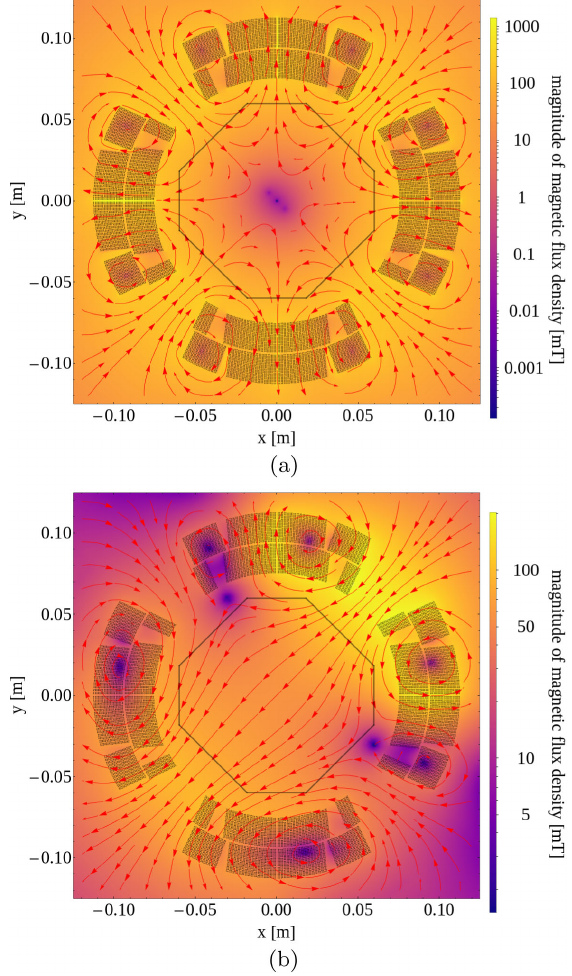
FIG. 6. The magnetic field induced by a CLIQ discharge in the IP1 and IP5 final focusing triplet magnets, 5 ms after firing. The black lines show the beam screen and the black dots the cable positions. The CLIQ unit modulates the current in the main coil of the magnet. (a) Q2 - skew octupolar field (b) Q1/Q3 - normal and and skew dipolar fields (the beam screen corresponds to Q3).